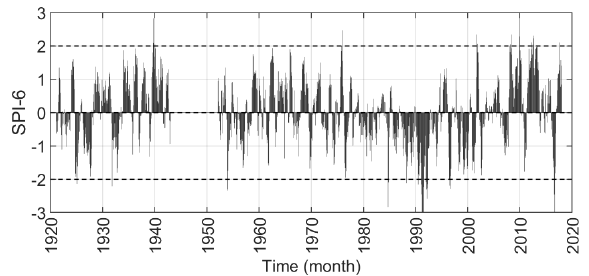
Figure 5. Temporal evolution of SPI-6 spanning from 1920 to 2018 (rainfall data were recorded at the Gioi Cilento weather station).